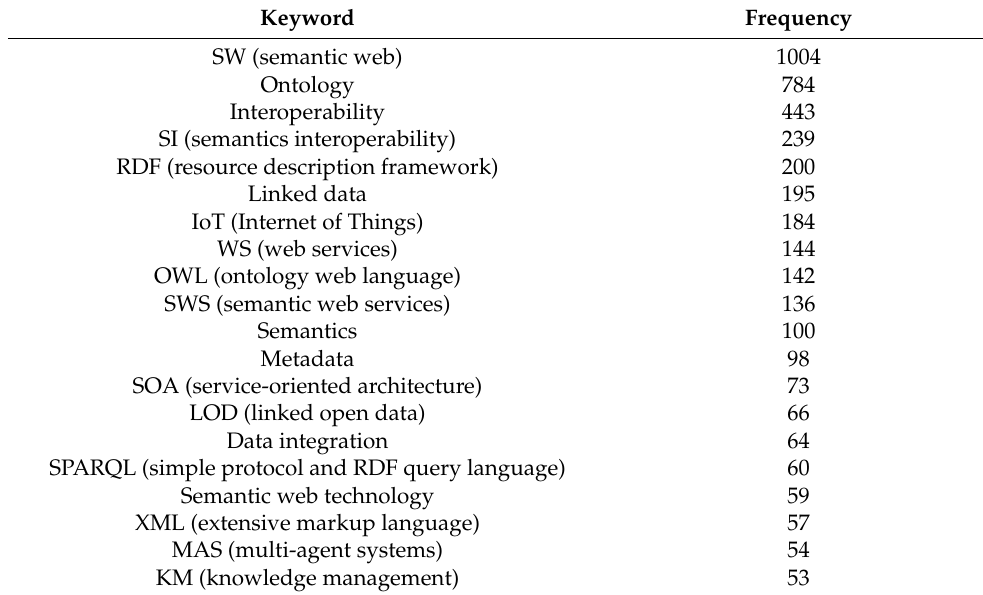
Table 6. Top 20 most frequent keywords.